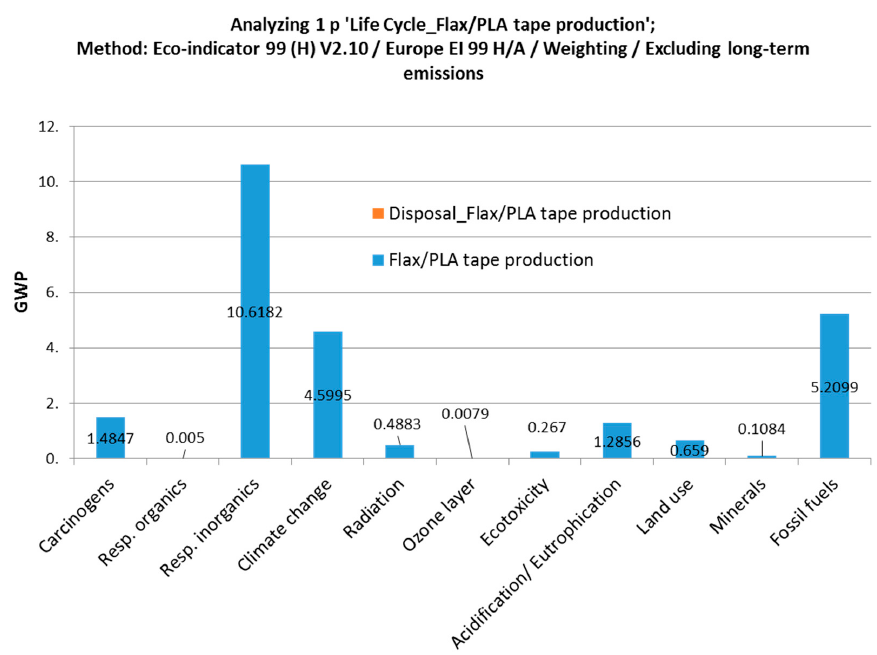
Figure 12. SimaPro 8: Environment impact of composite Flax tape overall environmental coverage.